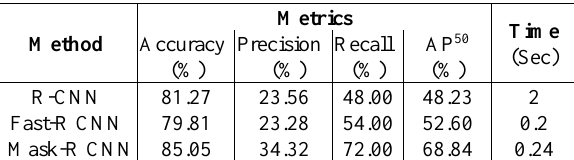
Table 1 . Performance comparison among R-CNN, Fast-R CNN and Mask-R